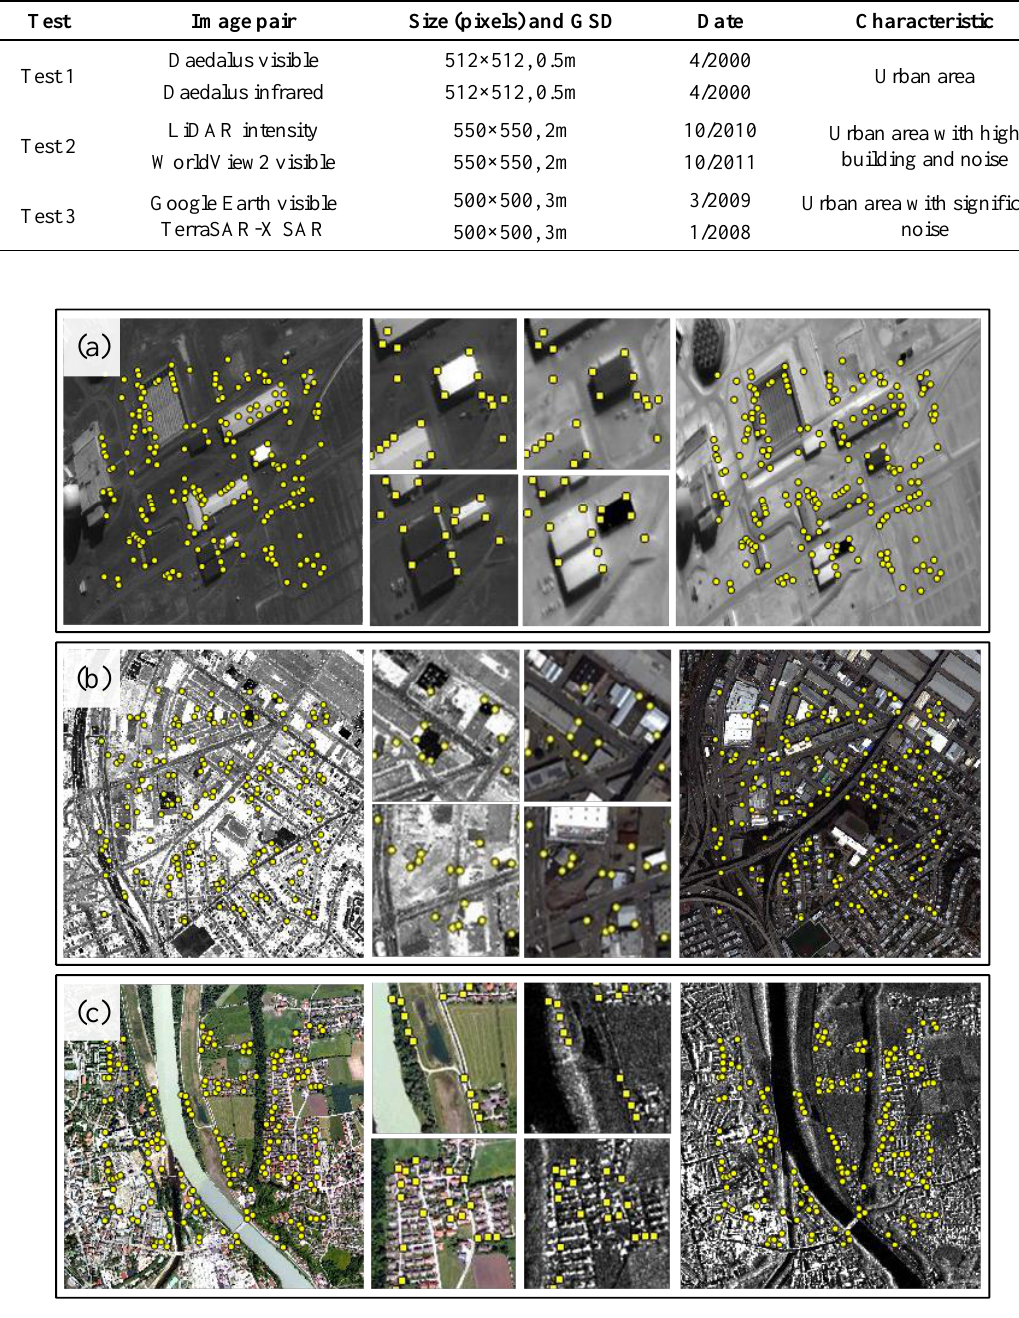
Figure 4. The CPs identified by M-HOPC (template size 100×100 pixels) for image pairs. (a) Test 1: Visible-to-Infrared. (b) Test 2: LiDAR-to-Visible. (c) Test 3: